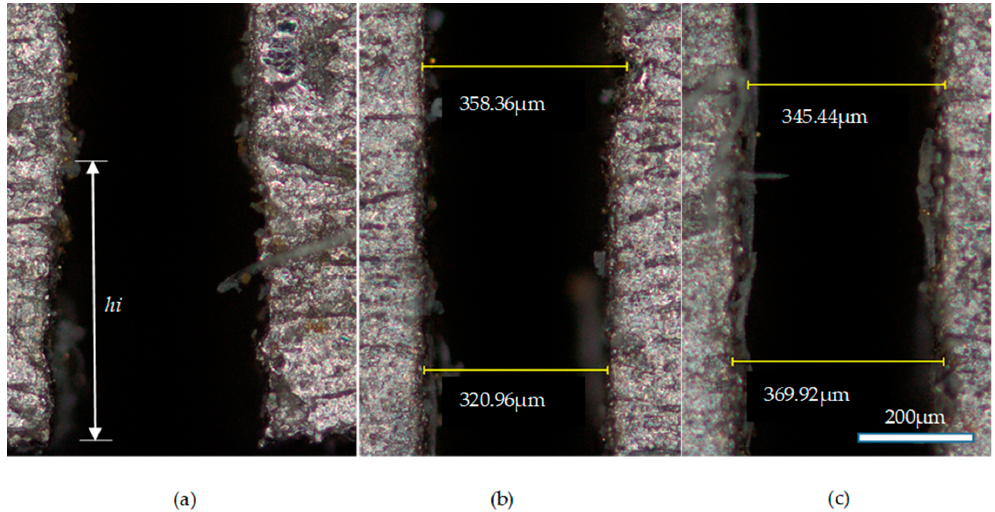
Figure 4. The photographs used in the measurements of kerf width KW: ( a )—kerf with initial zone, ( b )—kerf for run 1, ( c )—kerf for run 5, h i —depth of initial